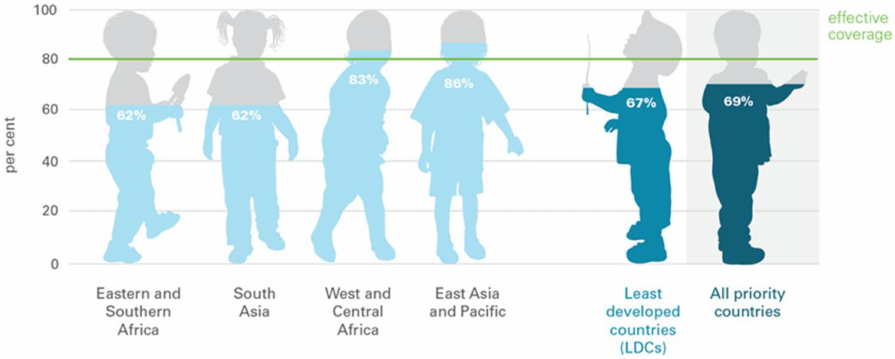
Figure 1. Vitamin A deficiency among the least developed countries (United Nations Children’s Fund